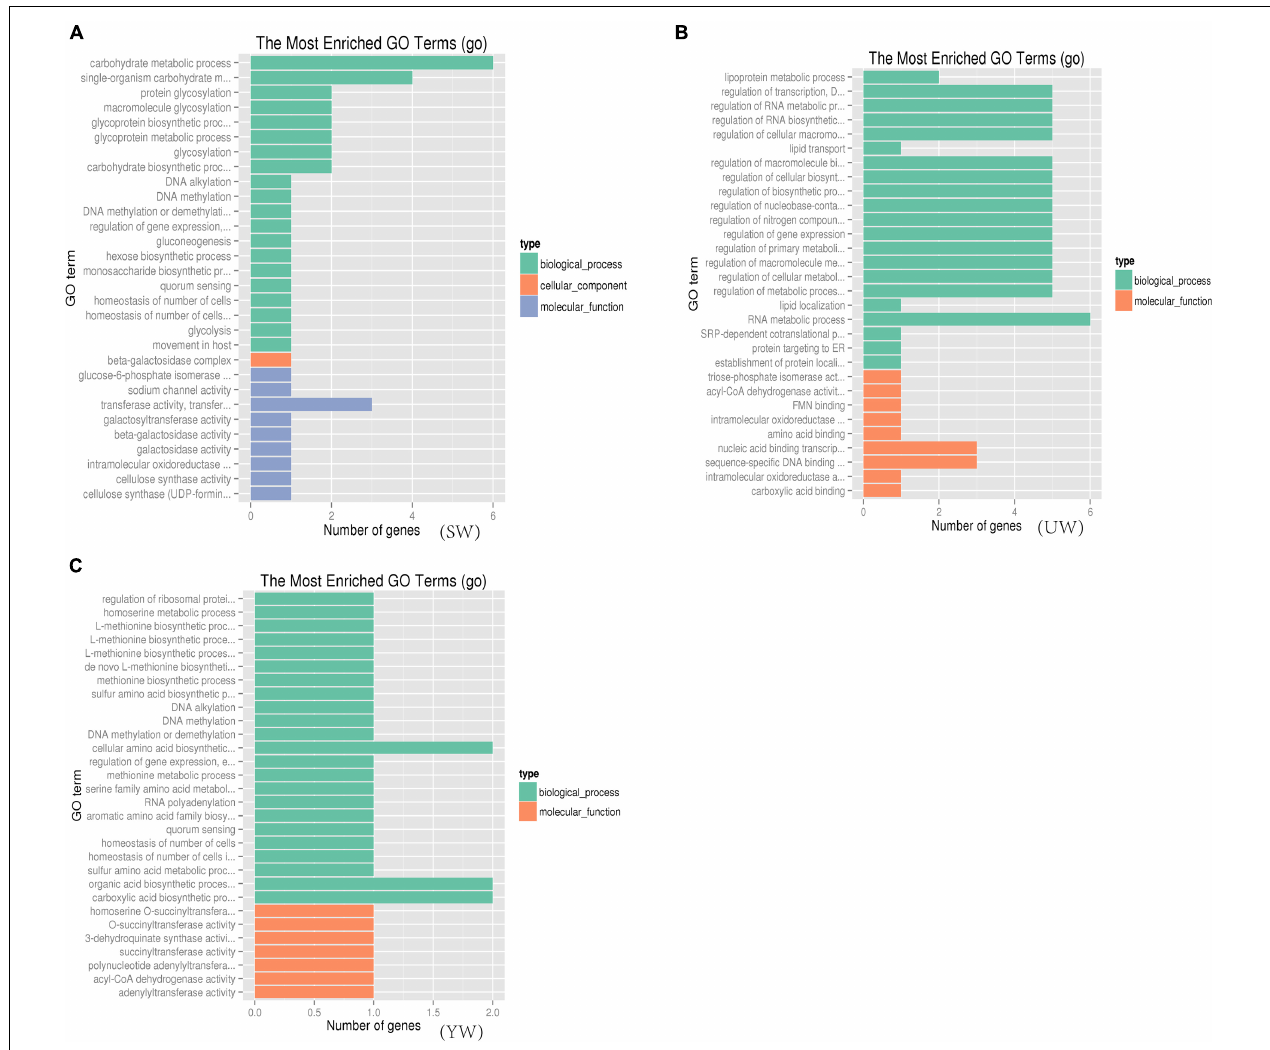
FIGURE 6 | Gene ontology (GO) functional significance enrichment analysis based on candidate gene. (A–C) Represents G. uralensis of central, eastern and southern regions,